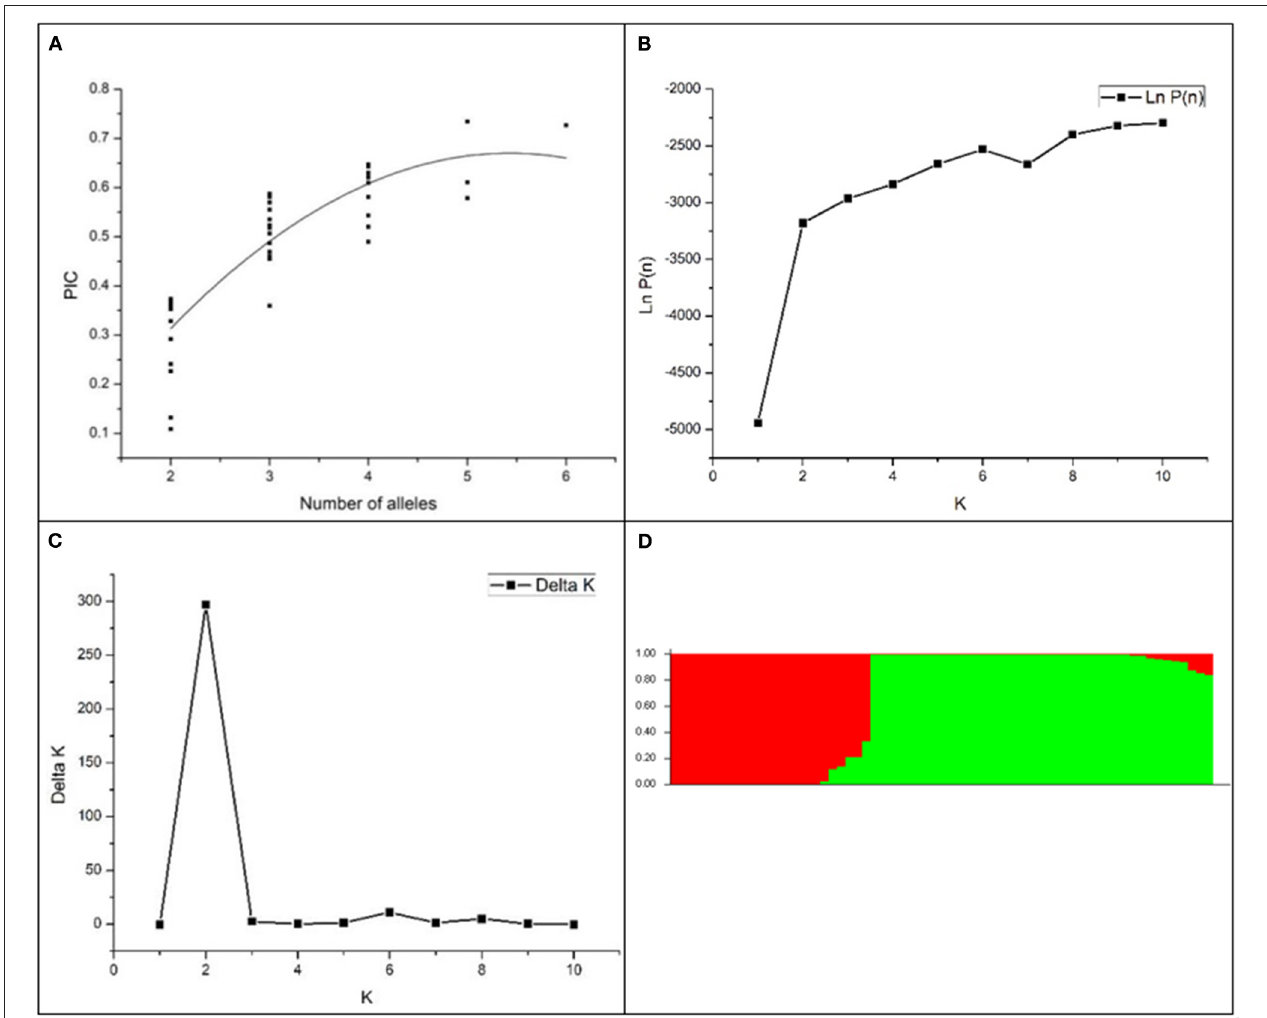
FIGURE 1 | The population structure and divergence of 63 rice cultivars. (A) a scatter plot of PIC vs. the number of alleles per SSR locus; (B) the mean Ln P (D) changed with the number of subgroups; (C) the 1 K value changed with the number of subgroups; (D) population structure distribution of 63 glutinous accessions. Red, the japonica group; green, the indica